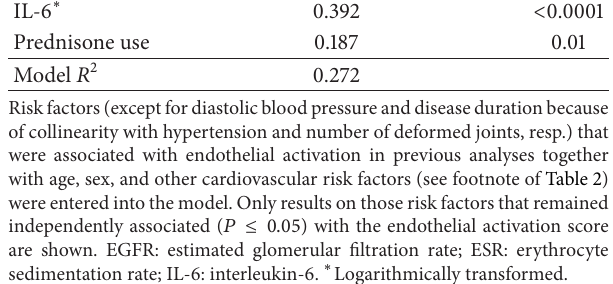
Figure1:Comparisonofthemagnitudeoftheeffectofinterleukin-6 concentrations versus those of the estimated glomerular infiltration rate and prednisone use on the endothelial activation score in models in Table